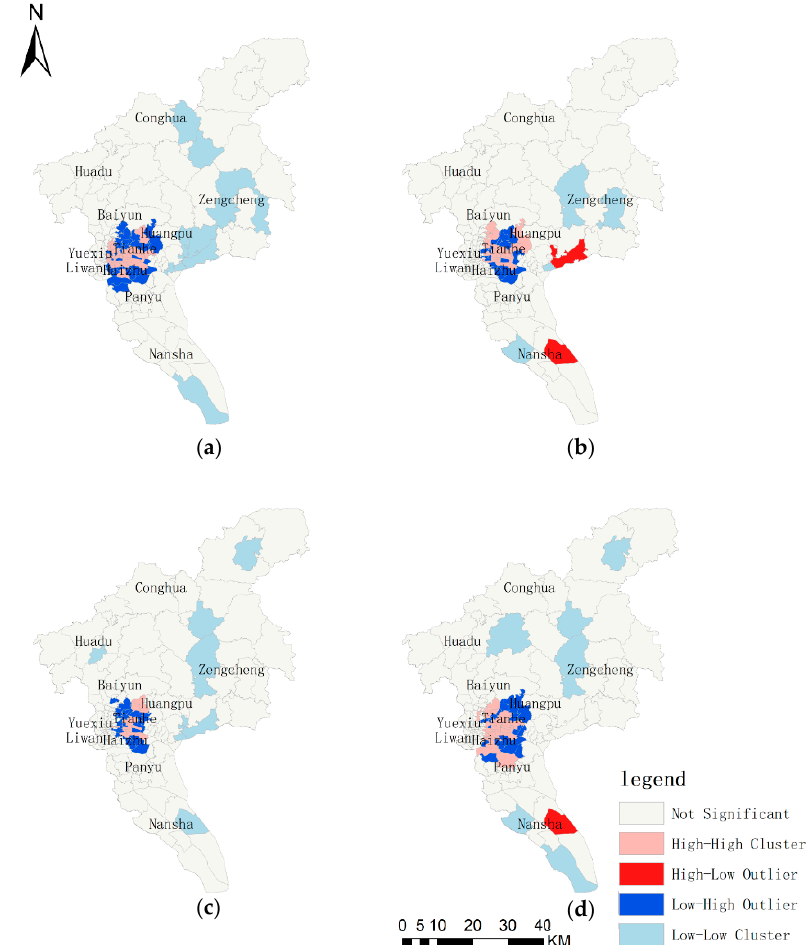
Figure 8. The distributions of four POI types in check-in quantity: ( a ) represents the food; ( b ) represents the hotel; ( c ) represents the entertainment; ( d ) represents the residential.